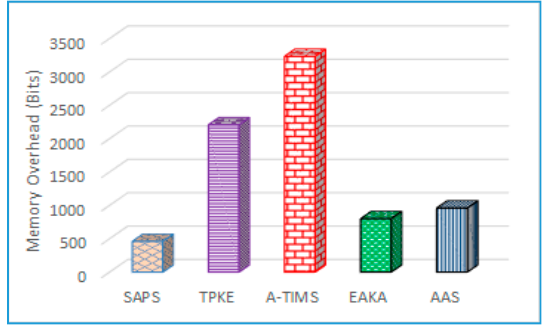
Figure 4. Storage cost for Secure Authentication and Prescription Safety (SAPS).